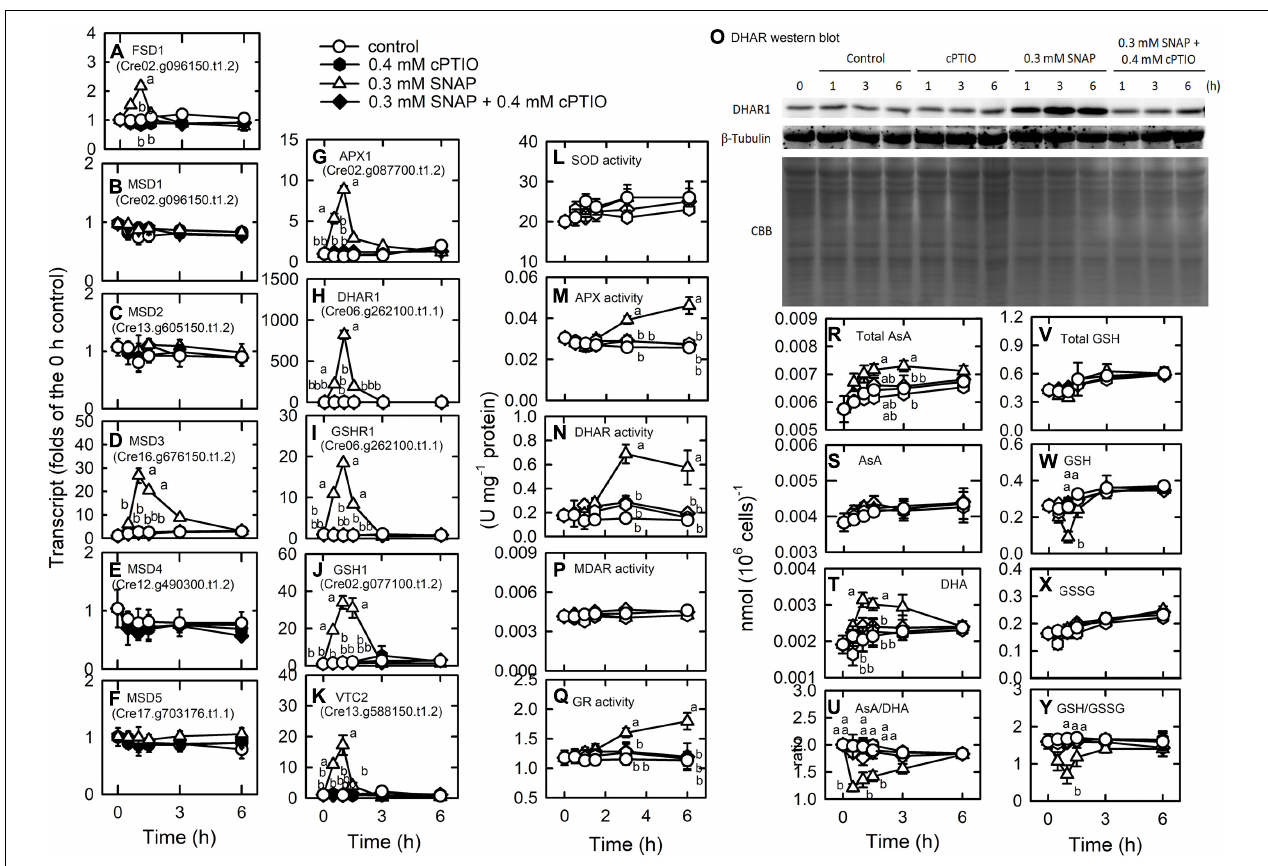
FIGURE 7 | Effects of NO on the expression of genes encoding proteins involved in antioxidant defense system. Time-course changes in the transcript abundances of FSD1 (A) , MSD1 (B) , MSD2 (C) , MSD3 (D) , MSD4 (E) , MSD5 (F) , APX1 (G) , DHAR1 (H) , GSHR1 (I) , GSH1 (J) , and VTC2 (K) ; the activity of SOD (L) , APX (M) , and DHAR (N) , DHAR western blot (O) , the MDAR (P) , and GR (Q) activity; the concentrations of total AsA (R) , AsA (S) , and DHA (T) ; the ratio of AsA/DHA (U) ; the concentrations of total GSH (V) , GSH (W) , and GSSG (X) ; and the ratio of GSH/GSSG (Y) in C. reinhardtii after exposure to 0.3 mM SNAP in the presence or absence of 0.4 mM cPTIO. Data are expressed as the mean ± SD ( n = 3). Different symbols indicate significant differences between treatments (Scheffe’s test, P <